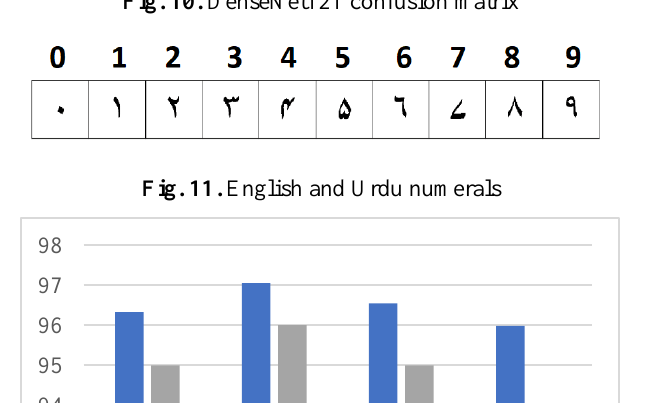
Fig. 10. DenseNet121 confusion matrix